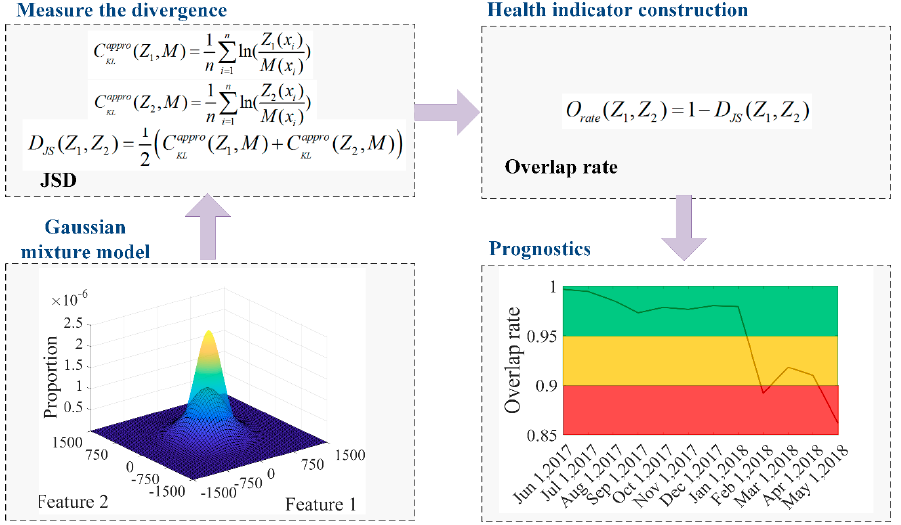
Figure 5. Flow chart of fault prognostics.